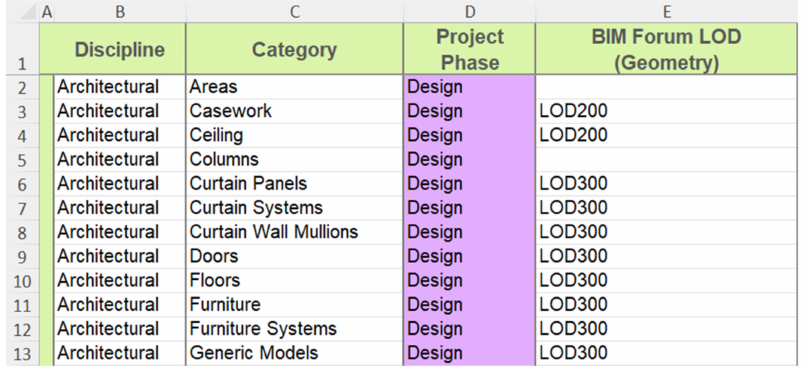
Figure 9. Partial screenshot of the DGS spreadsheet showing the expected LoD for each category of object at a certain phase of the